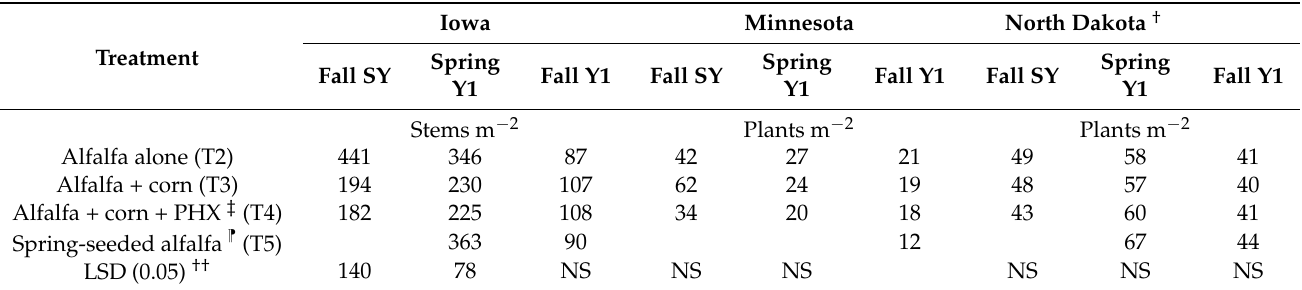
Stem density in the fall of the seeding year was greater for alfalfa established alone (T2) in Iowa environments (Table 9). As expected, in the fall of the first production year the spring-seeded alfalfa treatment (T5) had the greatest stem density in Iowa. However, in both Minnesota and North Dakota environments plant density was not different among treatments ( p > 0.05) (Table 9). Stem density from the fall in the seeding year to the next spring decreased in Iowa by 21% for the alfalfa alone (T2). In Minnesota, plant density reduction ranged between 36% and 61% depending on the treatment. The application of PHX did not improve alfalfa stand survival and shading by corn only reduced alfalfa stands in Iowa. Table 9. Plant density or stem density of alfalfa for each treatment in the fall of the seeding year (Fall SY), the spring of the first production year (Spring Y1) and in the fall of the first production year (Fall Y1).